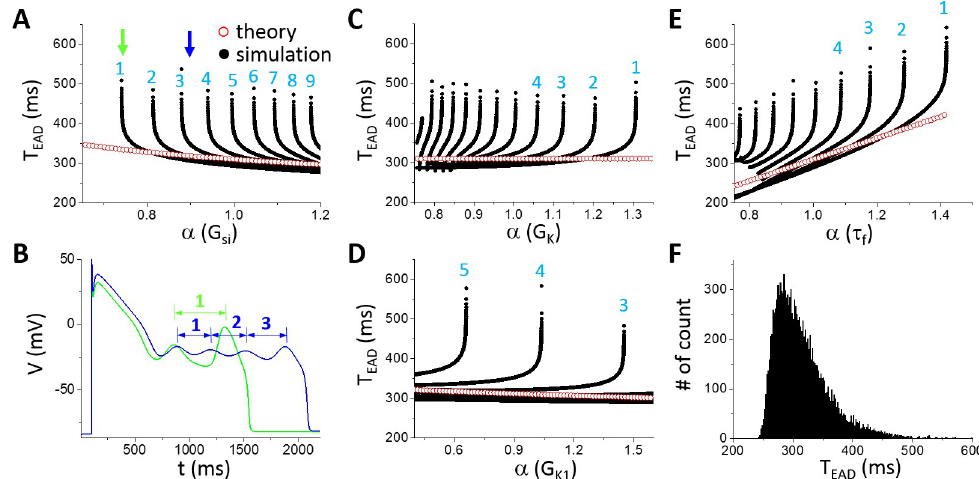
Fig 6. Theoretical predictions and simulation results of T EAD using the LR1 model. A . T EAD versus G si . The numbers mark the order of T EAD as defined in B. B . AP traces for G si indicated by the two arrows in A with two EADs and one T EAD in the green AP ( α = 0.741) while four EADs and three T EAD in the blue AP ( α = 0.9). C . T EAD versus G K . D . T EAD versus G K1 . E . T EAD versus τ f . F . Histogram of T EAD obtained from a large number of simulations using randomly selected parameter sets and all T EAD in an AP. Control τ f ( α = 1) was used. The total number of T EAD is 13317 in the histogram.